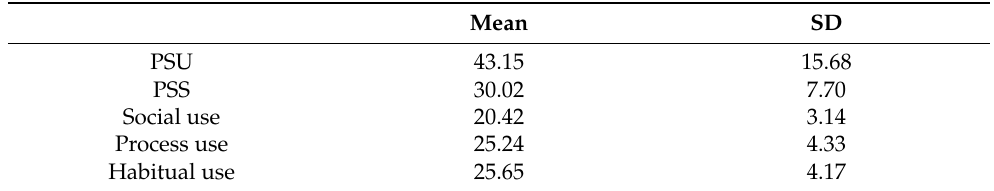
Table 1. Descriptive statistics for MPPUS, PSS, and type of use (social use, process use, and habit- ual use).